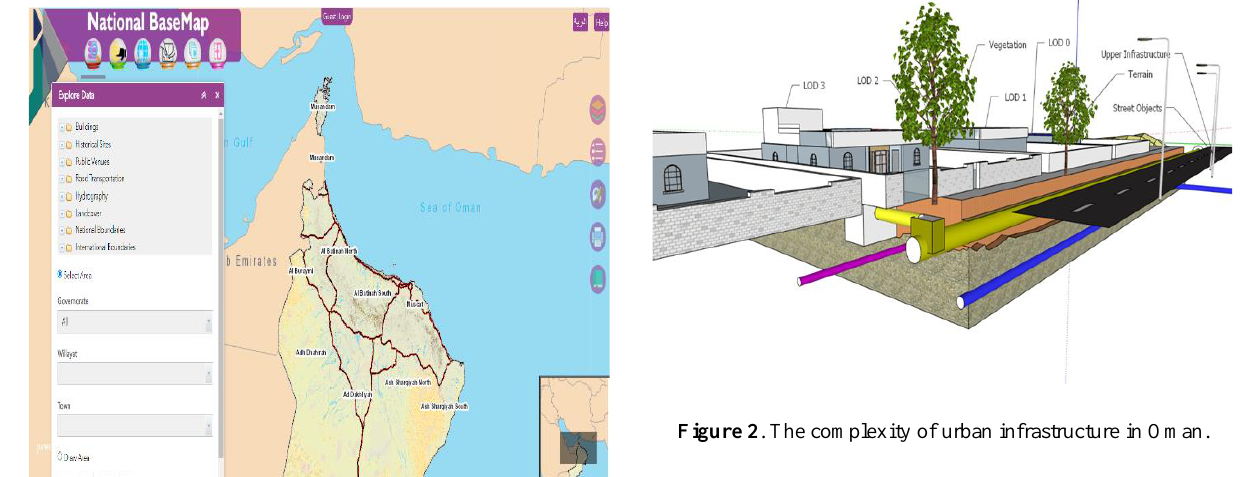
Figure 4. The project achieved creating Digital Aerial Oblique Color Photography 4 - Directional - 10cm resolution for 3D city model facades for the main cities in Qatar (i.e., Al Doha, Al Khor and Al Wakra). Furthermore, the project created Aerial LiDAR having 5cm vertical accuracy with 4 points per sq. meter point cloud and Aerial Triangulation for all urban areas including the coastline. The project generated a 3D City Model with absolute (30cm horizontal and 25cm vertical) accuracy with LoD2 and LoD3 for the same